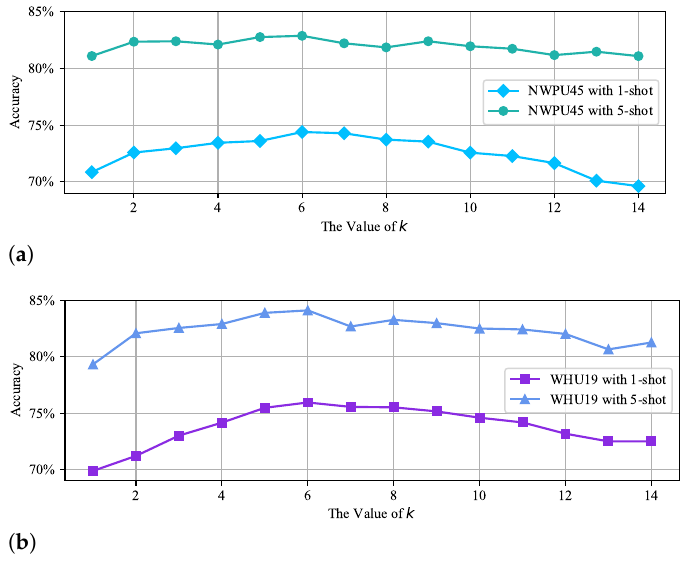
12 different values ranging from 0.5 to 3. Experimental results on NWPU-RESISC45 and WHU-RS19 are presented in Figure 9.